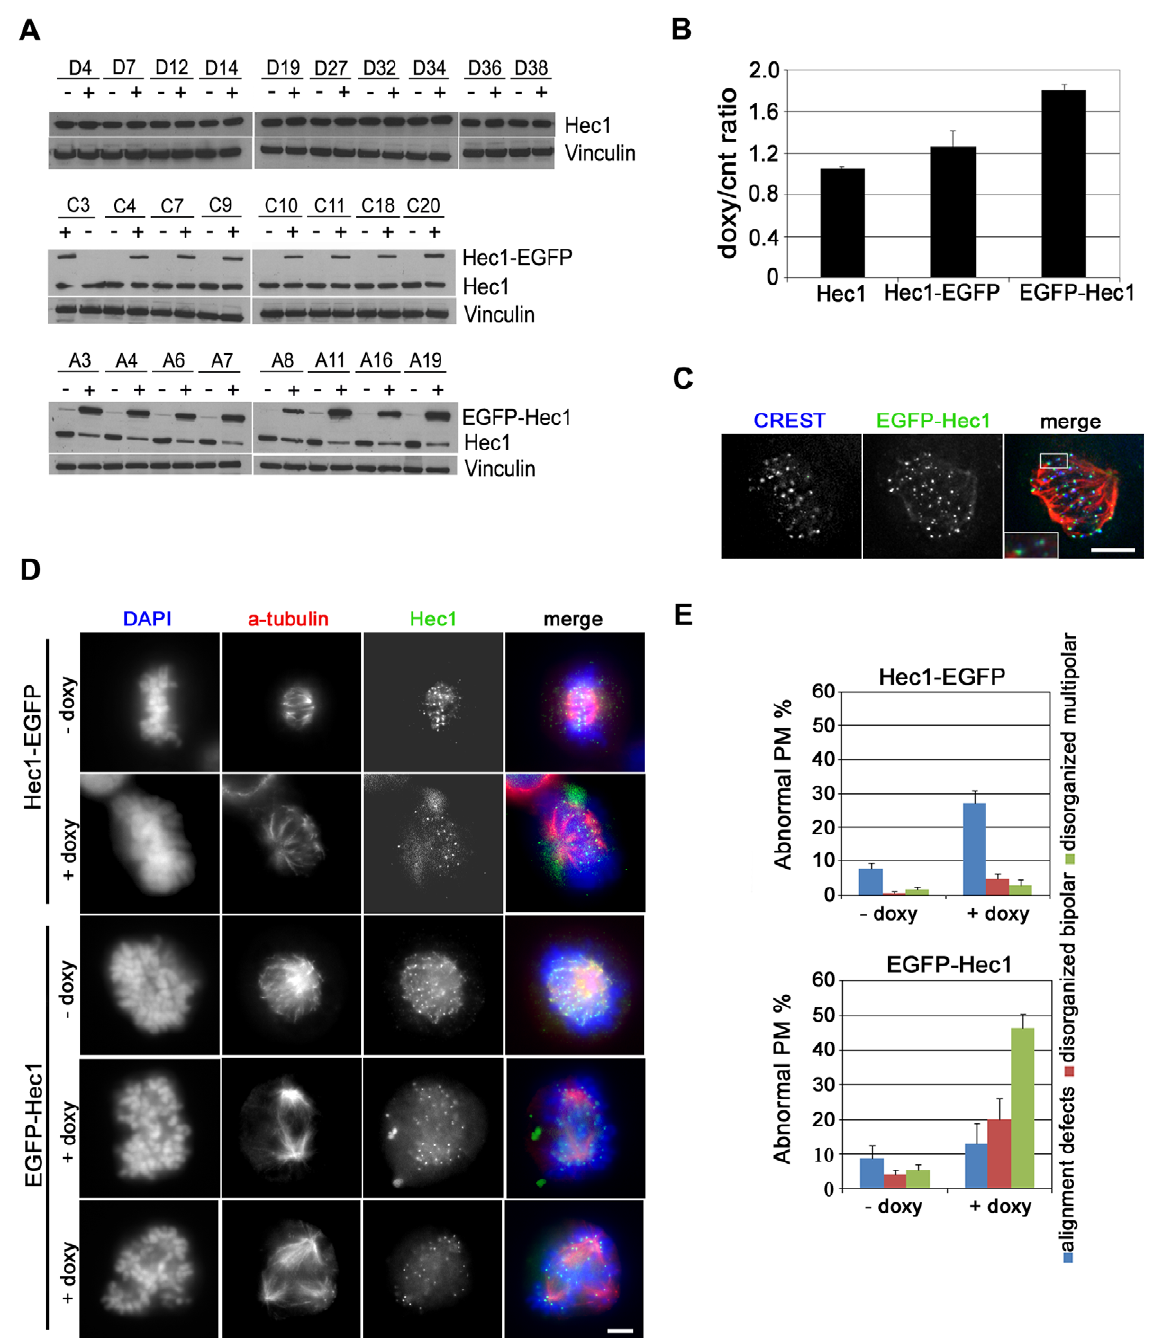
Figure 1. Inducible Hec1 expression in HeLa clones. (A) Western blot analysis using an Hec1 antibody before (-) and after ( + ) doxycycline addition in HeLa clones expressing Hec1 (D clones), Hec1-EGFP (C clones) or EGFP-Hec1 (A clones). (B) Densitometric analysis of Hec1 expression in the different clones as measured by the ratio of totalHec1 (endogenous + exogenous) in induced (doxy) vs uninduced (cnt) conditions after normalization forvinculin expression. Data are mean 6 SE of the ratios obtained in clones expressing untagged Hec1 (n=10), Hec1-EGFP (n=8) or EGFP-Hec1 (n=8). (C) EGFP- Hec1 (green) localization after doxy induction in a prometaphase cell stained for CREST (blue) and tubulin (red). The boxed 2-fold enlargement shows EGFP-Hec1 localization with respect to the inner kinetochore marker CREST. Bar, 5 m m. (D) Chromosome congression and spindle organization before (- doxy) and after ( + doxy) induction of Hec1-EGFP or EGFP-Hec1 expression as shown by a -tubulin (red) and DAPI (blue) staining. In uninduced samples Hec1 is visualized by antibody staining (green). Hec1-EGFP/-doxy: normal metaphase; Hec1-EGFP/ + doxy: late prometaphase with unaligned chromosomes; EGFP-Hec1/-doxy: normal prometaphase; EGFP-Hec1/ + doxy (fourth row): disorganized bipolar prometaphase; EGFP-Hec1/ + doxy (last row): disorganized multipolar prometaphase. Bar, 5 m m. (E) Quantitative analysis of prometaphase abnormalities in Hec1-EGFP or EGFP-Hec1 expressing clones. Data are mean 6 SE of 300 prometaphases (PM) for each condition in three independent experiments. Alignment defects were significantly higher in Hec1-EGFP expressing mitoses than in uninduced cells (P , 0.01, t-test); disorganized bipolar prometaphases (P , 0.05, t-test) and disorganized multipolar prometaphases (P , 0.01, t-test) were significantly higher in EGFP-Hec1 expressing mitoses than in uninduced mitoses.